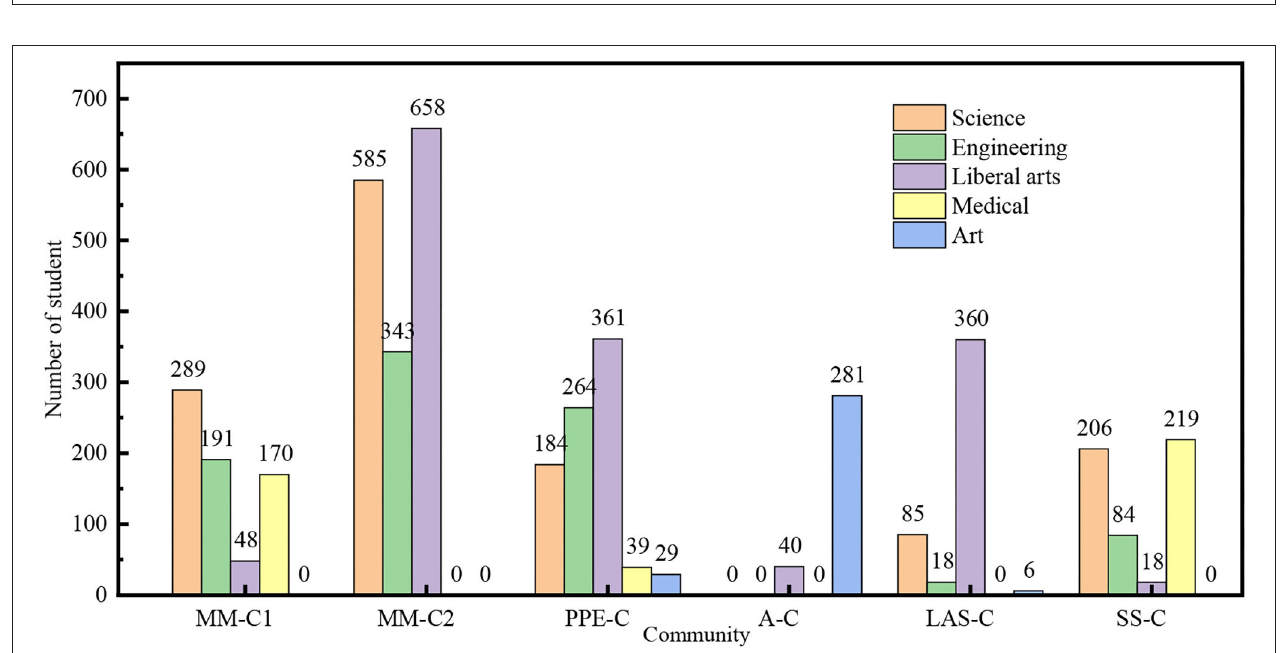
FIGURE 3 | Educational background distribution in the community.